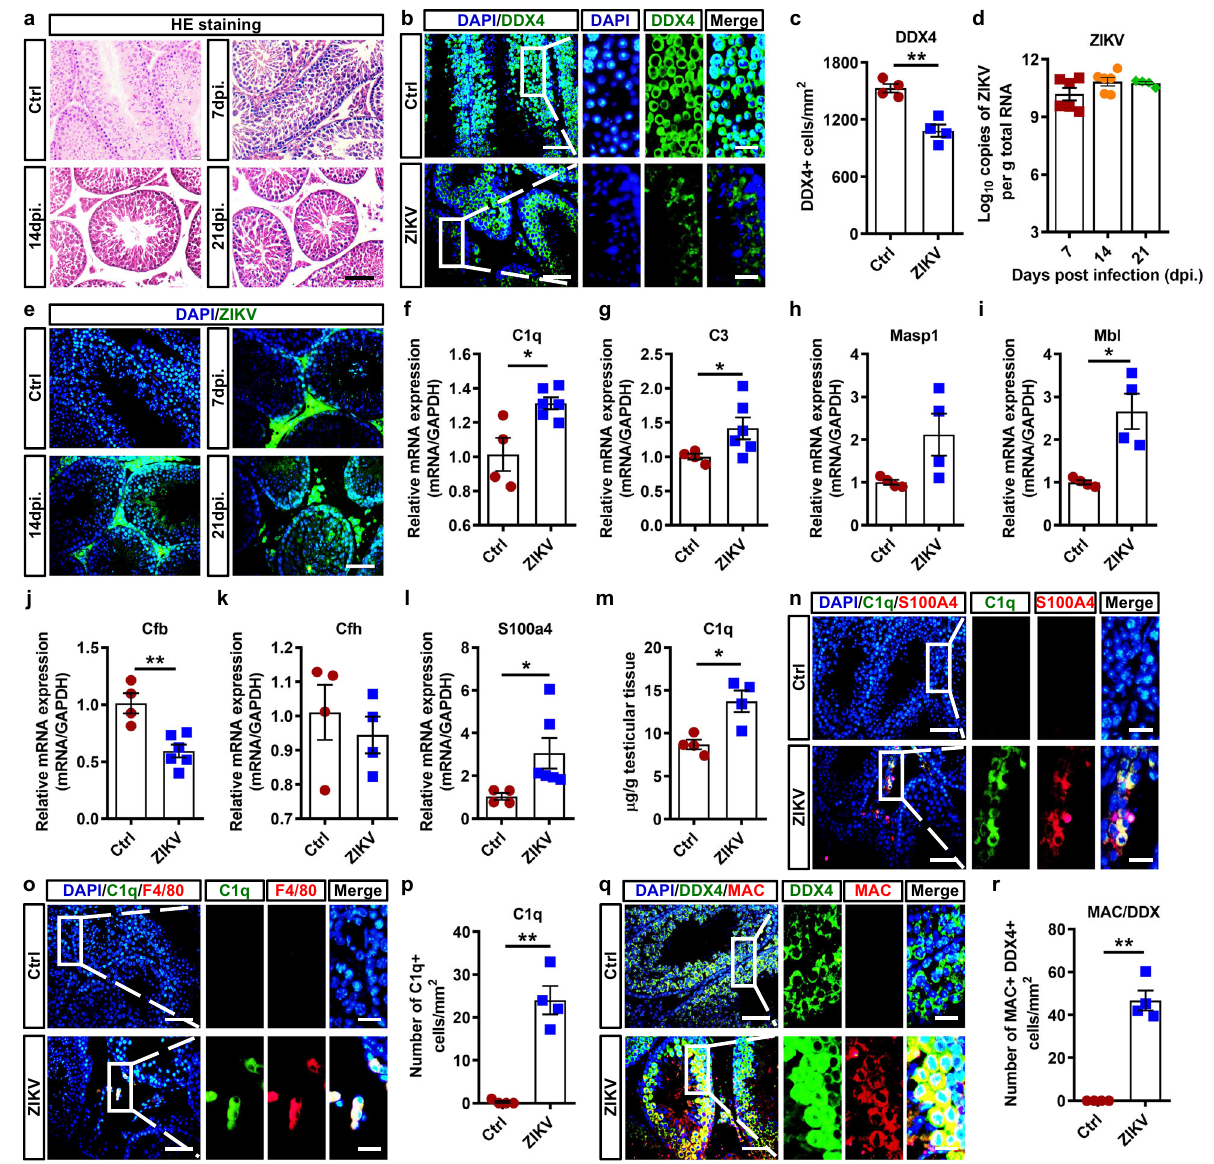
Fig. 6 | ZIKV-induced spermatogenic cell damage and complement activation intestesfromhSTAT2KImice.a HEstainingoftestesfromZIKV-infectedhSTAT2 KImice.Scalebar,25 μ m. b , c IFAwithanti-DDX4antibodyintestisfromcontrolor ZIKV-infected hSTAT2 KI mice at 14 dpi. b Number of DDX4+ spermatogenic cells/ mm 2 ( c ) were shown as means±SEM and analyzed using the two-sided Student ’ s t test. ** p <0.01. ( n =4 testes for each group). Scale bar, 25 μ m. (10 μ m in enlarged panels). d ZIKVviralloadintestesofZIKV-infectedhSTAT2KImice( n =4testesfor eachgroup).Resultswereshownasmeans±SEMandanalyzedusingthetwo-sided Student ’ s t test. e The distribution of ZIKV antigens in testis from control or ZIKV- infected hSTAT2 KI mice. Scale bar, 25 μ m. f – m The relative RNA expression of complement components ( f – k ) and S100a4 ( l ) and the concentration of C1q